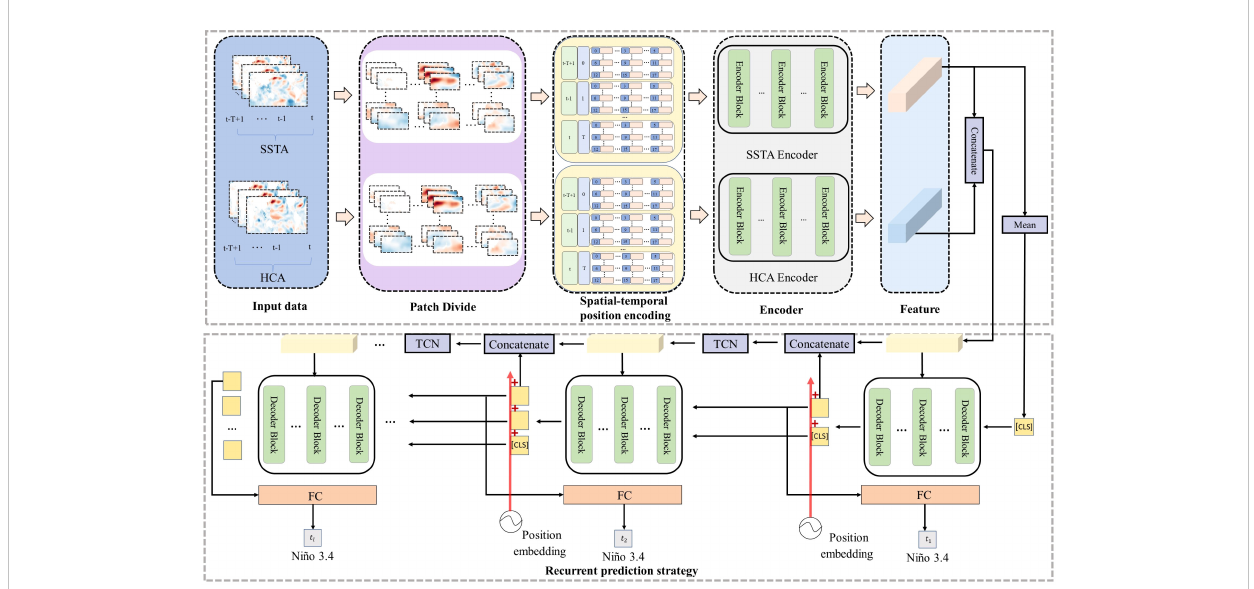
FIGURE 1 The proposed STTN model architecture, which contains Input data, Patch Divide, Spatial-temporal position encoding, Encoder, SSTA and HCA Features, and Recurrent prediction strategy. The SSTA and HCA encoder consist of multiple transformer encoder blocks. The Recurrent prediction strategy predicts the Niño3.4 index according to the time step. Input variables are SSTA (in units of °C) and HCA (in units of °C) from t - T +1 to t (in units of month).The STTN model outputs the Niño3.4 indexes for the next l